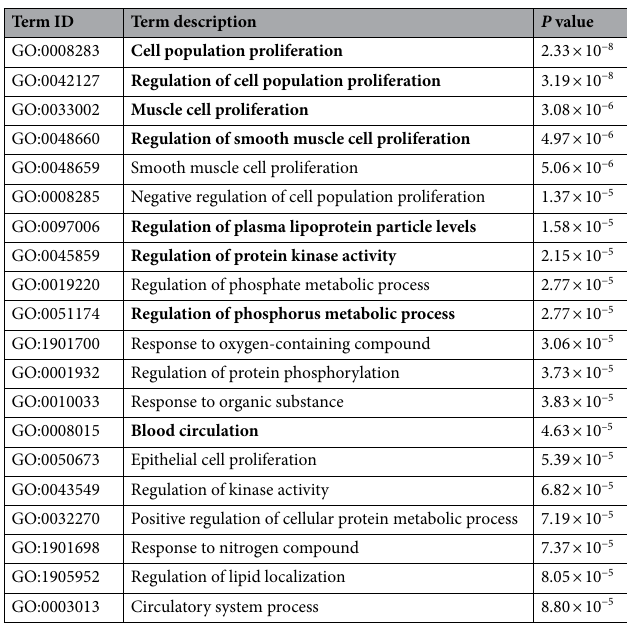
Table 3. List of top 20 gene ontology terms associated with the total SNPs associated genes in AAA. Bolded terms are annotated in the REVIGO clustering from Fig. 4. * P value was measured using the gost function in gprofiler2 R package (cumulative hypergeometric p-value).